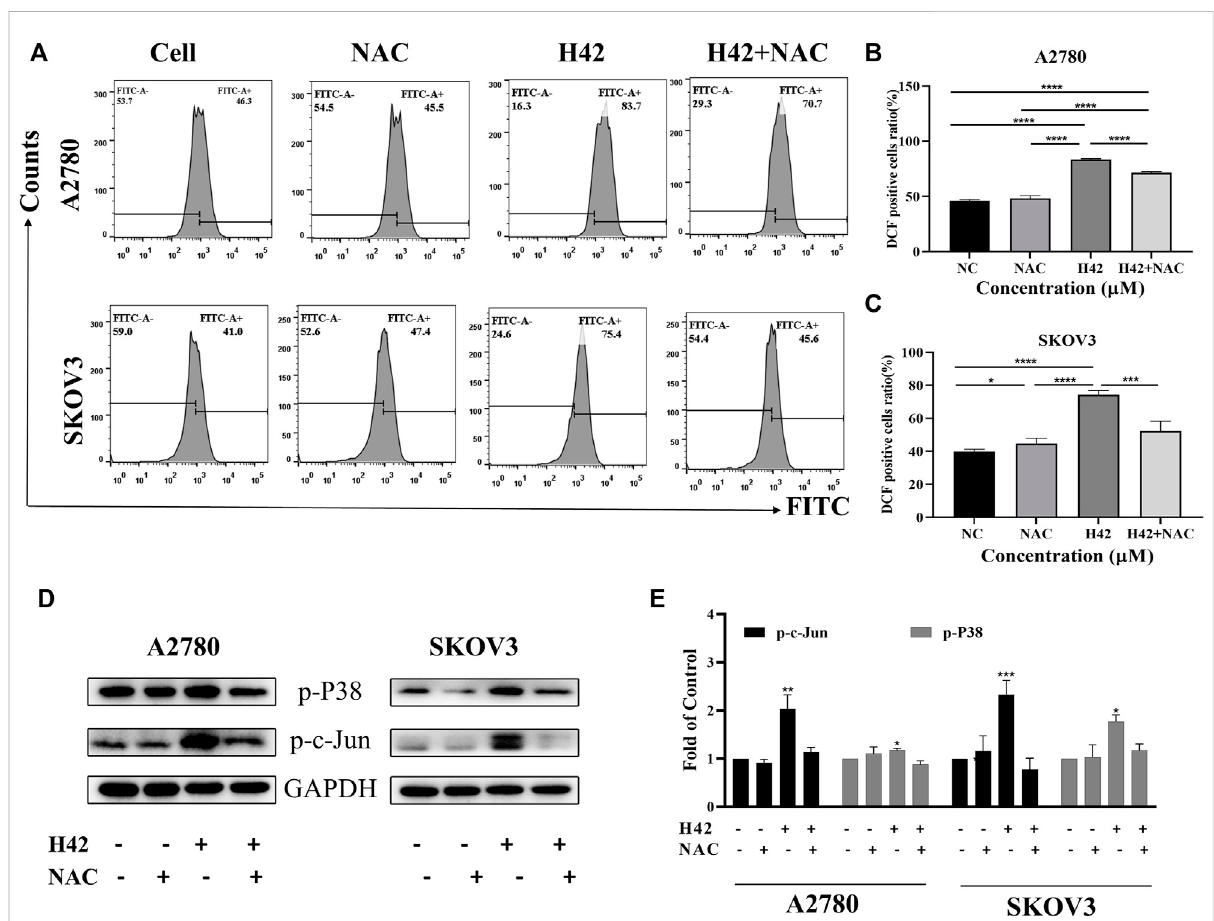
Compound H42-triggered ROS in A2780 and SKOV3 cells could be reversed by the ROS scavenger NAC. A2780 and SKOV3 cells were treated withDMSO,H42,NAC,orH42accompaniedbyNACfor48H. (A) CellularROSwasdetectedbytheDCFH-DAprobeusingFCM.Quantitativeanalysis ofROSgenerationisshownin (B,C) . (D) ExpressionofROS-relatedproteinsinA2780andSKOV3cellswasexaminedbyWesternblotand (E) analyzed in the density ratio. Data are all represented as mean ± SD of at least three independent experiments. * p < 0.05, ** p < 0.01, *** p < 0.001, and **** p < 0.0001 were compared with the